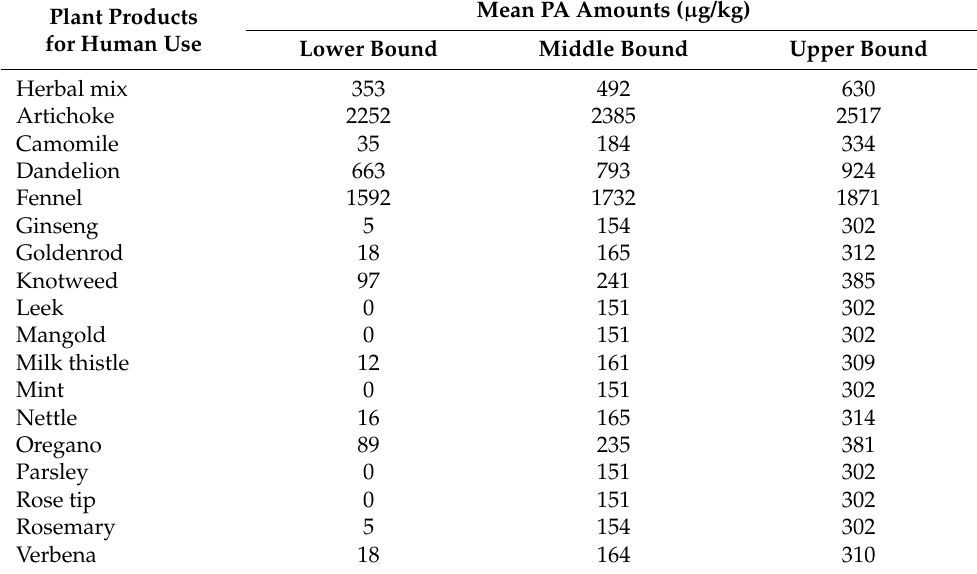
Table 2. Amounts of PAs in plant products for human